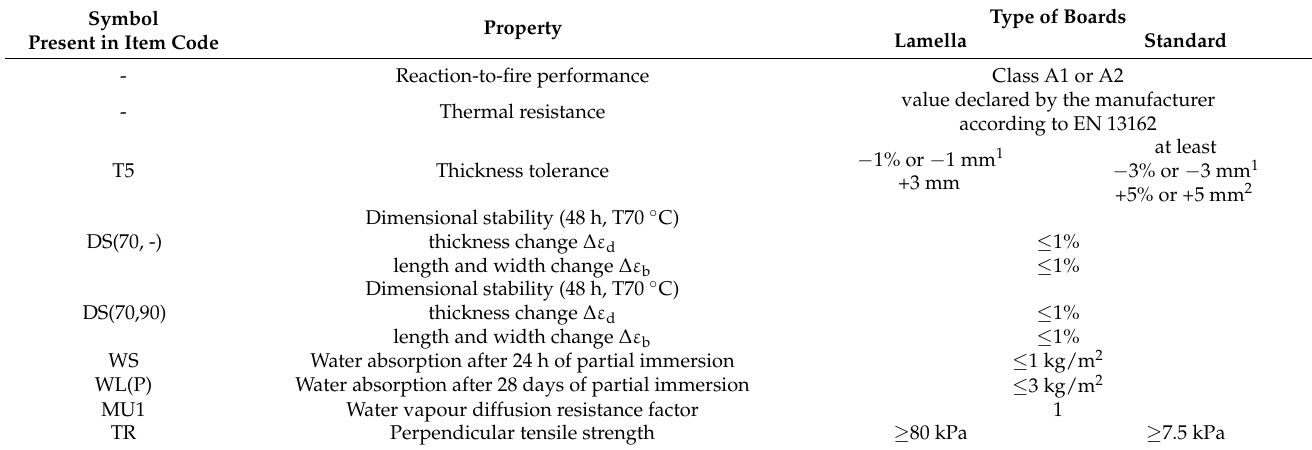
Table 1. Properties of mineral wool (MW) boards used in ETICS.